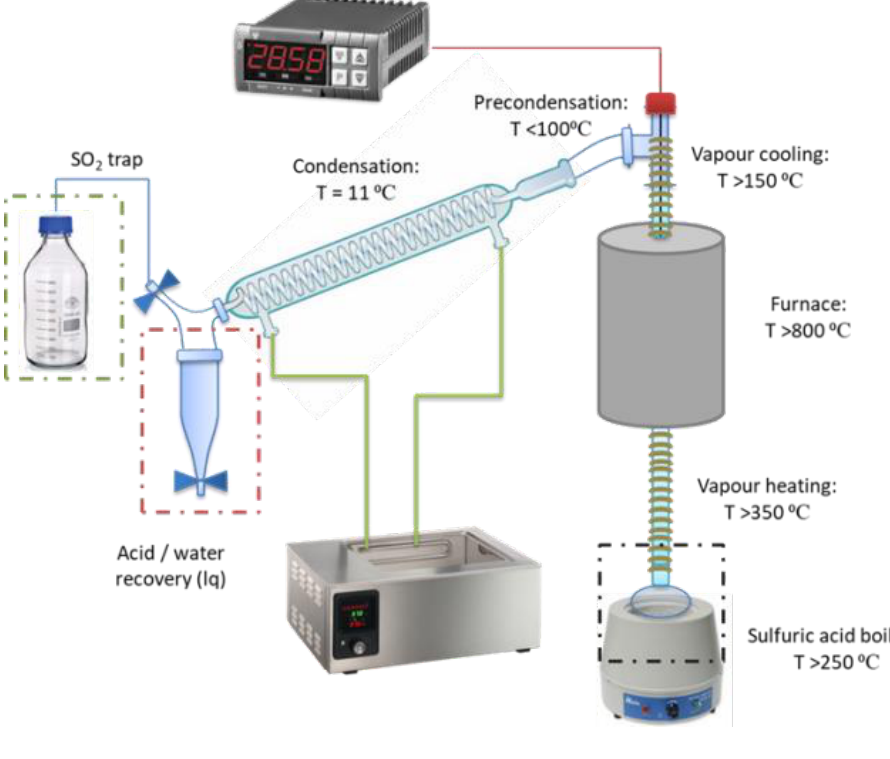
Figure 10. Experimental setup.